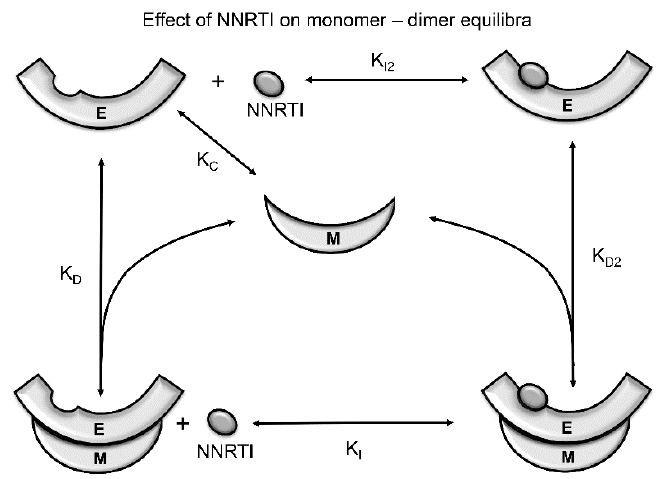
Figure 14. Effect of NNRTIs on RT conformational equilibria of the polymerase domain. The NNRTI binding site is present in the extended ( E ), but not the compact ( C ) or monomeric ( M ) conformation of the polymerase domain. It is assumed that the NNRTI can bind to the polymerase domain in the E conformation, whether it is present as a monomer (dissociation constant K I2 ) or a dimer (dissociation constant K I ). The NNRTI pocket is dynamic, and so the NNRTI probably selects the form suitable for complex formation. Isomerization is believed to occur prior to dimer formation, so that a small amount of monomer in the E conformation is expected to be present. In either pathway, the binding energy of the ligand alters the conformational equilibrium, favoring the formation of the NNRTI–dimer complex (based on Figure 10 of [25]).